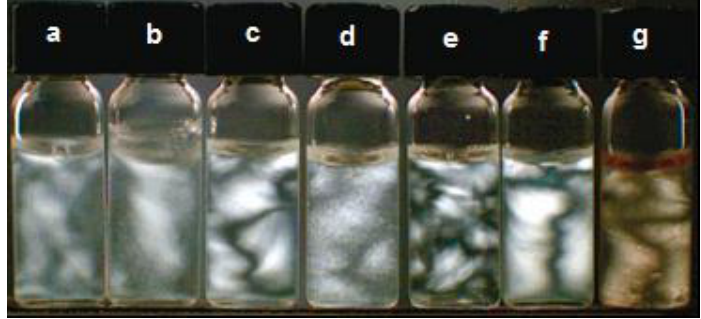
Figure 7. Birefringence phenomenon of lyophilized tunicin whiskers in different polar solvents. ( a ) In water (as it was prepared); or freeze-dried and re-dispersed in ( b ) water; ( c ) DMF; ( d ) DMSO; ( e ) N-methyl pyrrolidone; ( f ) formic acid, and ( g ) m-cresol